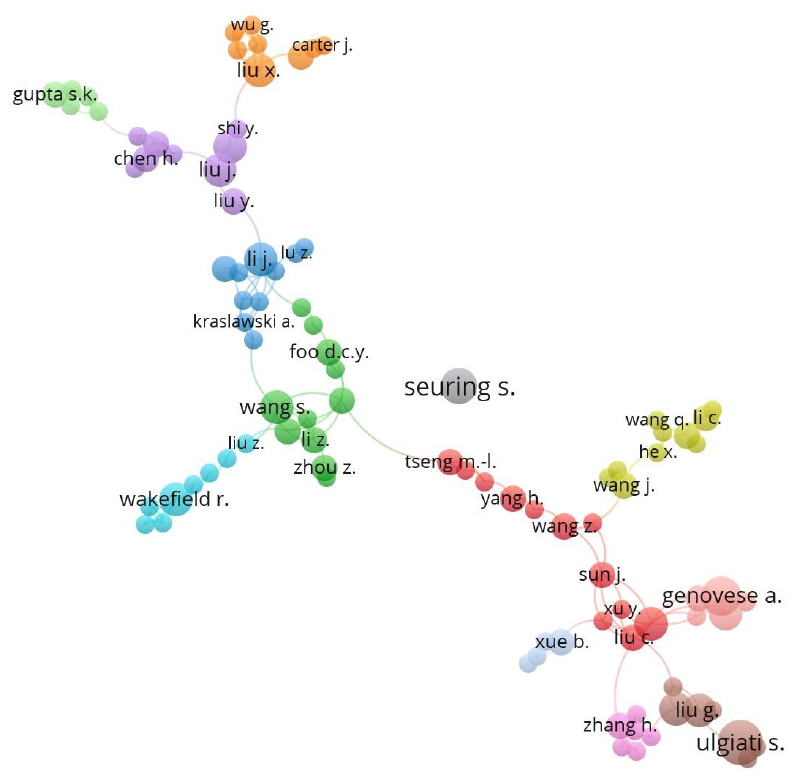
Figure 4. Network map of cooperation between authors based on co-authorship (1988–2019).